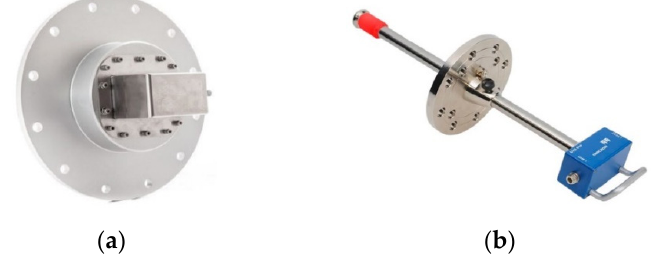
Figure 3. UHF sensors applied in a power transformer: ( a ) internal UHF sensor; ( b ) Omicron UVS 610 UHF valve sensor [28].